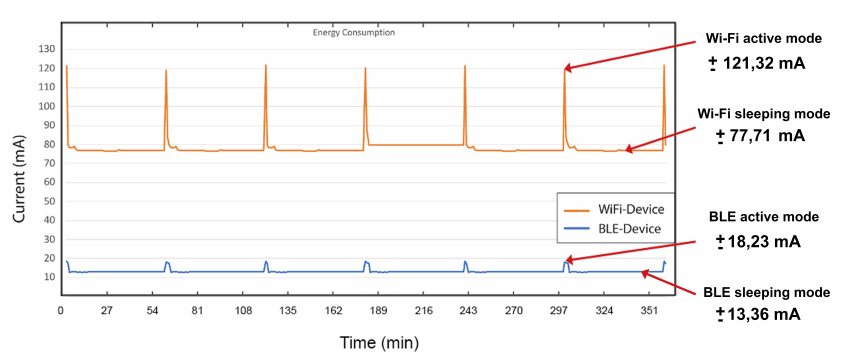
Figure 9. The current flowing into the devices as a function of time. The Wi-Fi board shows higher consumption in active and sleeping mode.